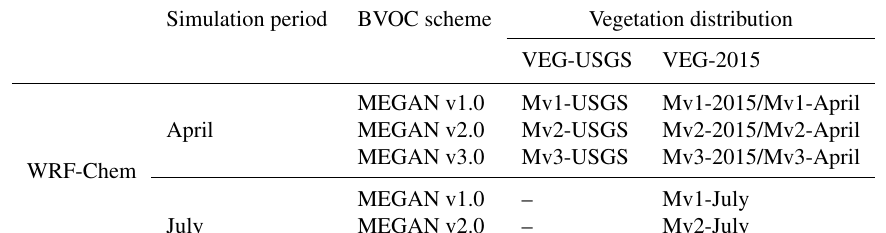
Table 3. Numerical experiments of WRF-Chem in this study.